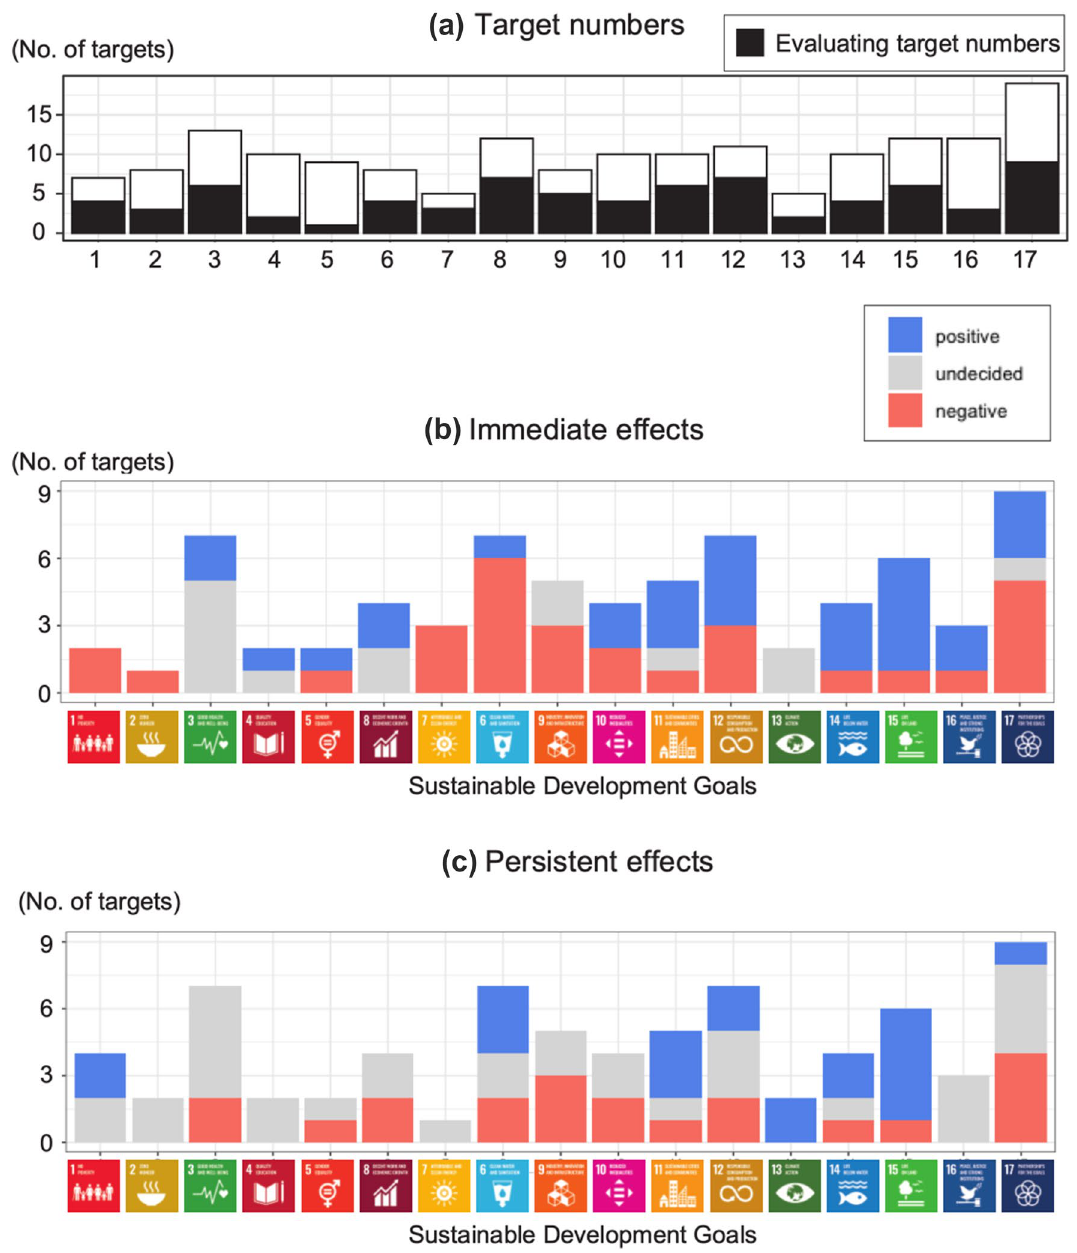
Fig. 5 Scoring of global lockdown effects on SDG targets. a Evaluated targets for each goal. Scores of b immediate and c persistent effects of global lockdown on each